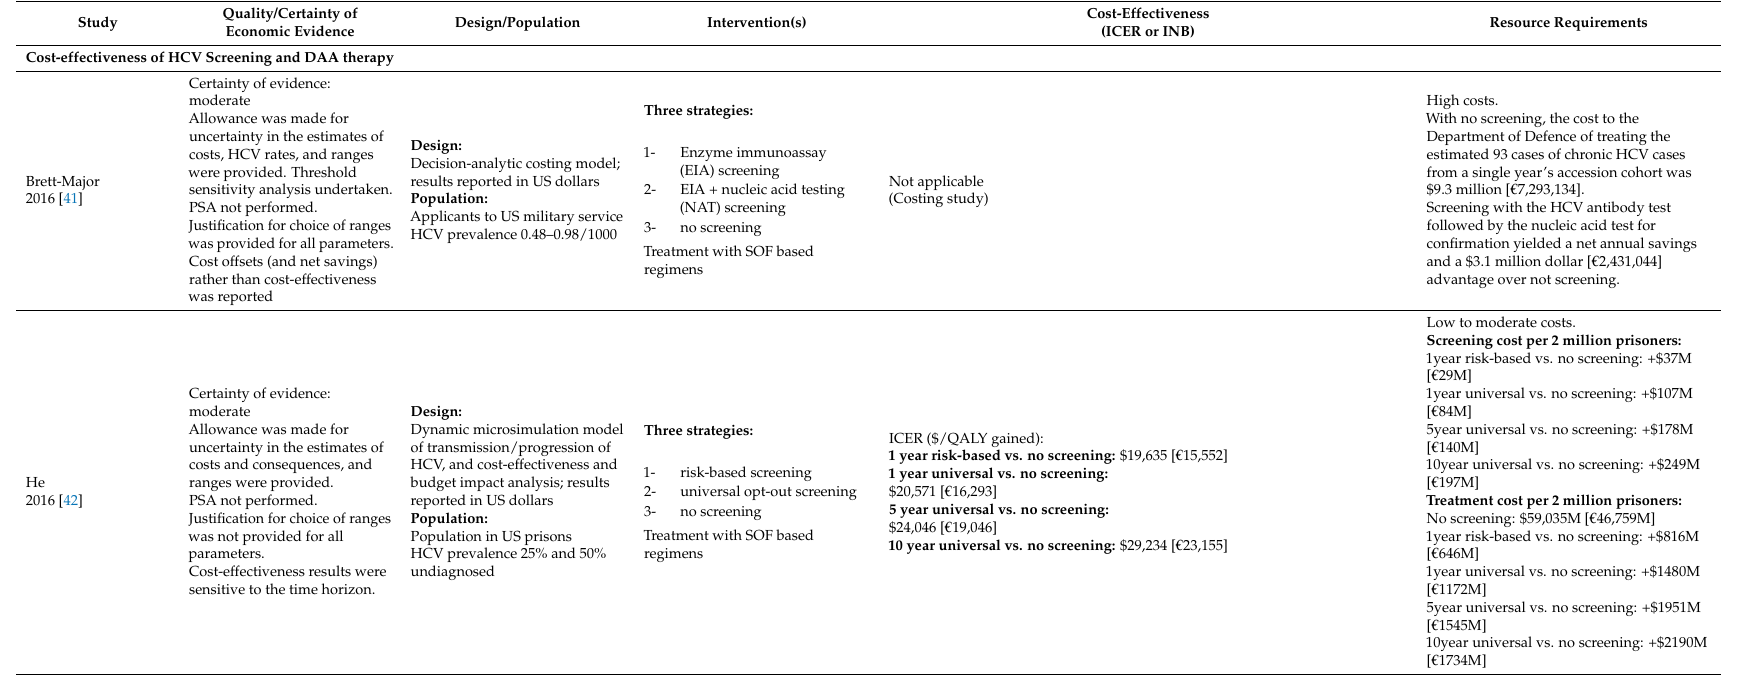
Table 2. Included studies on the cost, resource use, and cost-effectiveness of HCV screening and direct acting antiviral